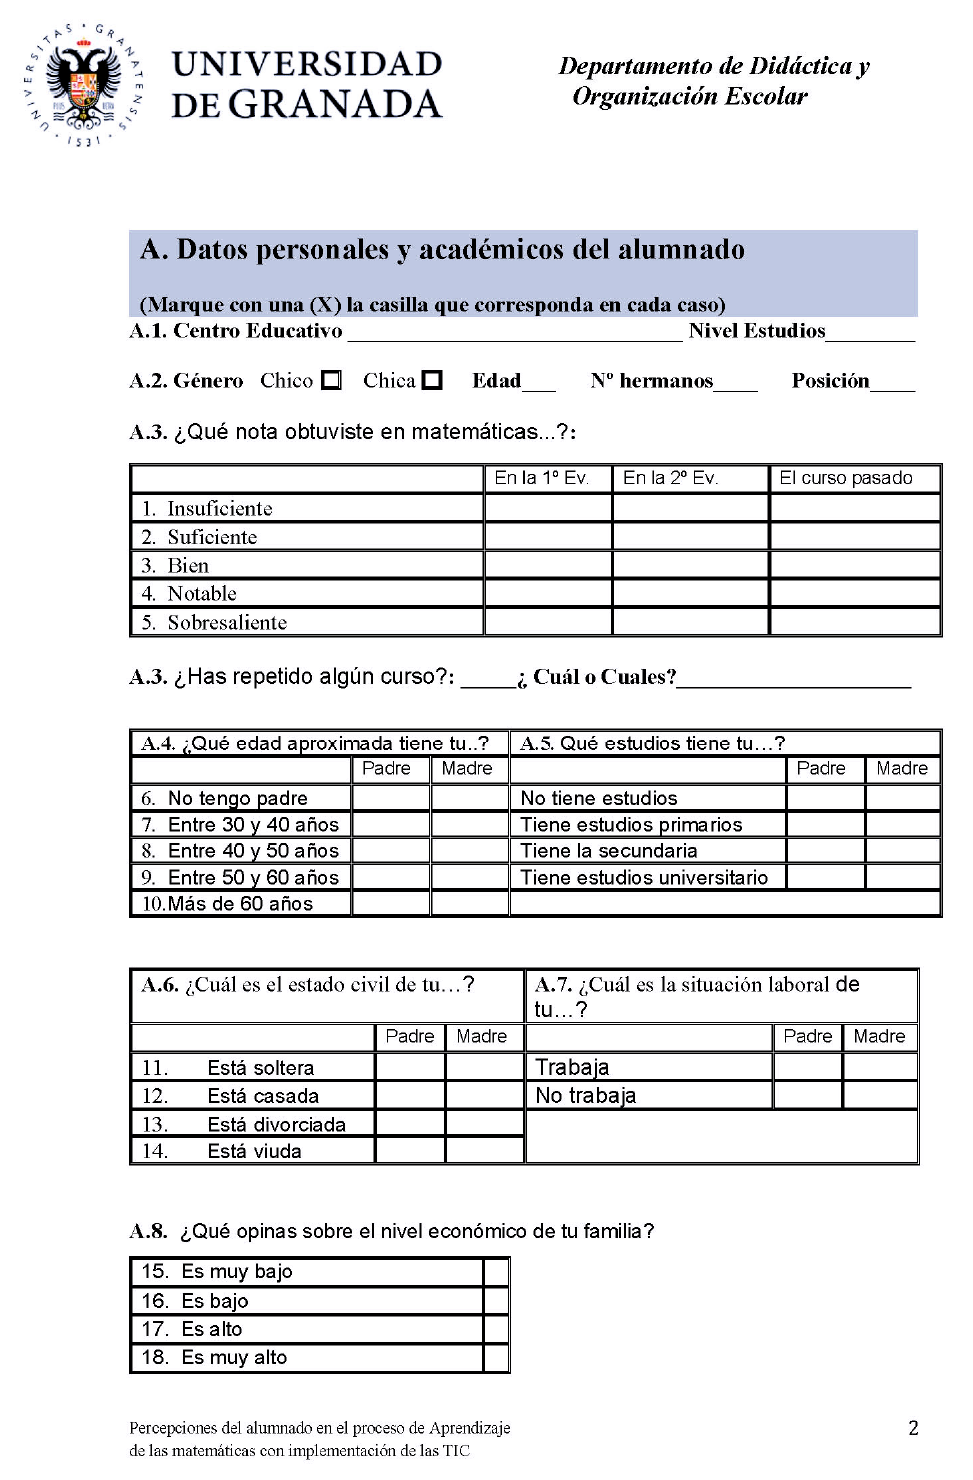
Figure A2. Items of dimension A “Student’s Personal and Academic Data”.